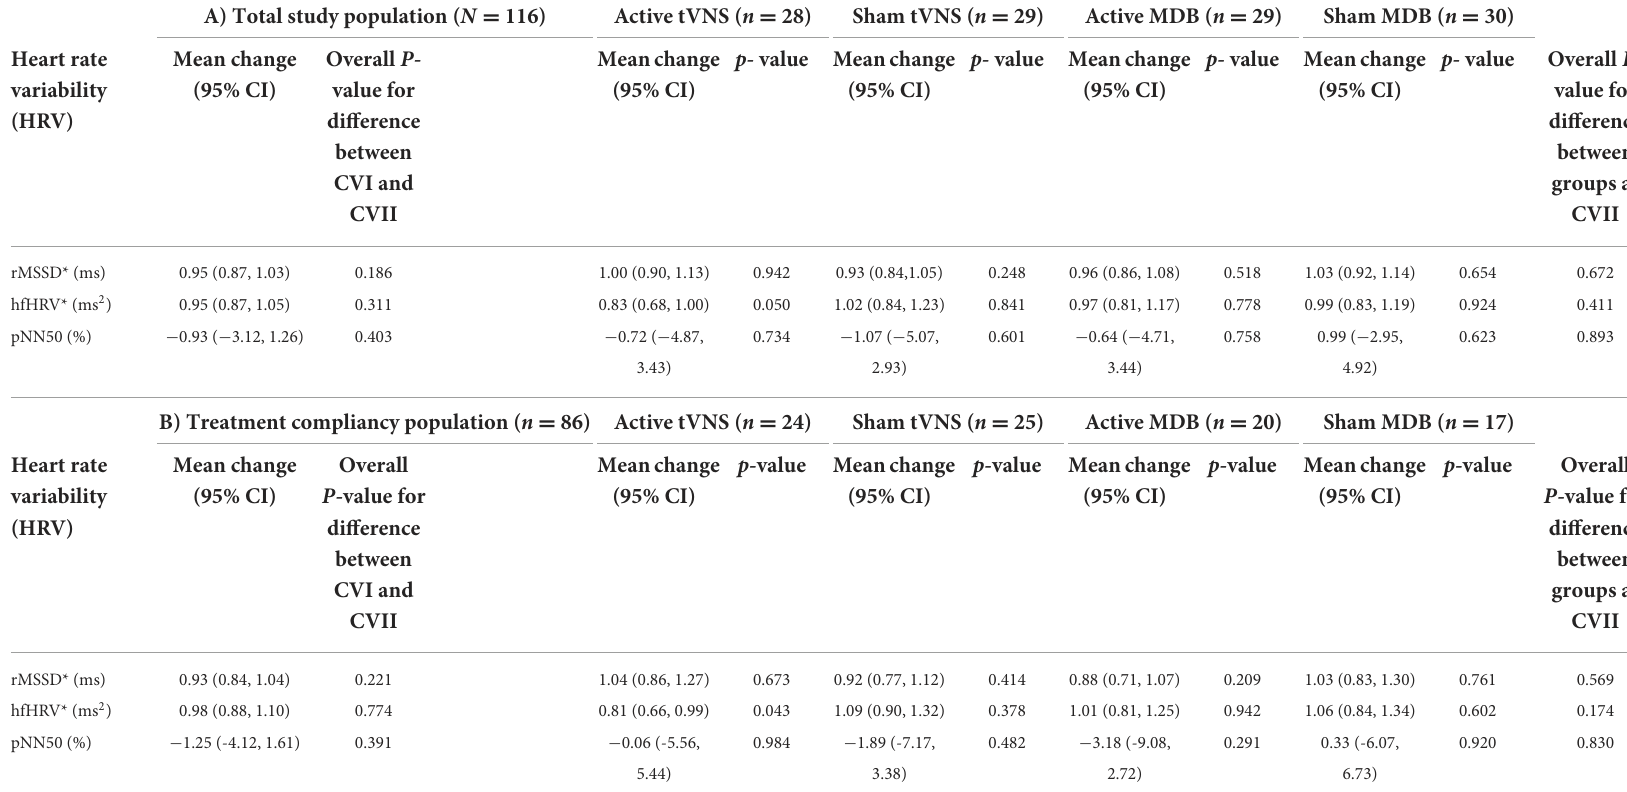
TABLE 3 Primary outcome: Mean (95% CI) differences between treatment groups at 2 wk follow-up for HRV and total average change in HRV from baseline to follow-up for total study population (A; N = 116) and treatment compliancy population (B; n = 86) (Imputed analyses adjusted for baseline differences). A) Total study population ( N =